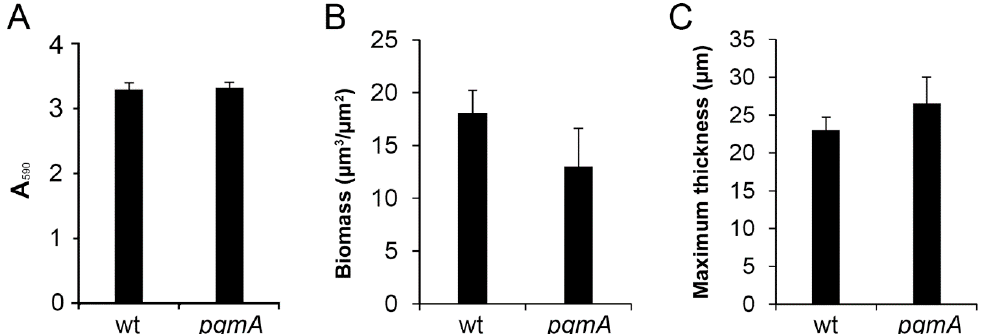
Figure 2. ( A ) Amount of biofilm formed by the S. mutans wild type and pgmA mutant in microtiter tray wells. Mean and standard deviations of six replicates are shown. ( B ) COMSTAT-calculated biomass of S. mutans wild type and pgmA mutant biofilms grown on submerged glass surfaces. ( C ) COMSTAT-calculated maximum thickness of S. mutans wild type and pgmA mutant biofilms grown on submerged glass surfaces. COMSTAT data are represented with mean and standard deviations calculated on six image stacks per experiment.